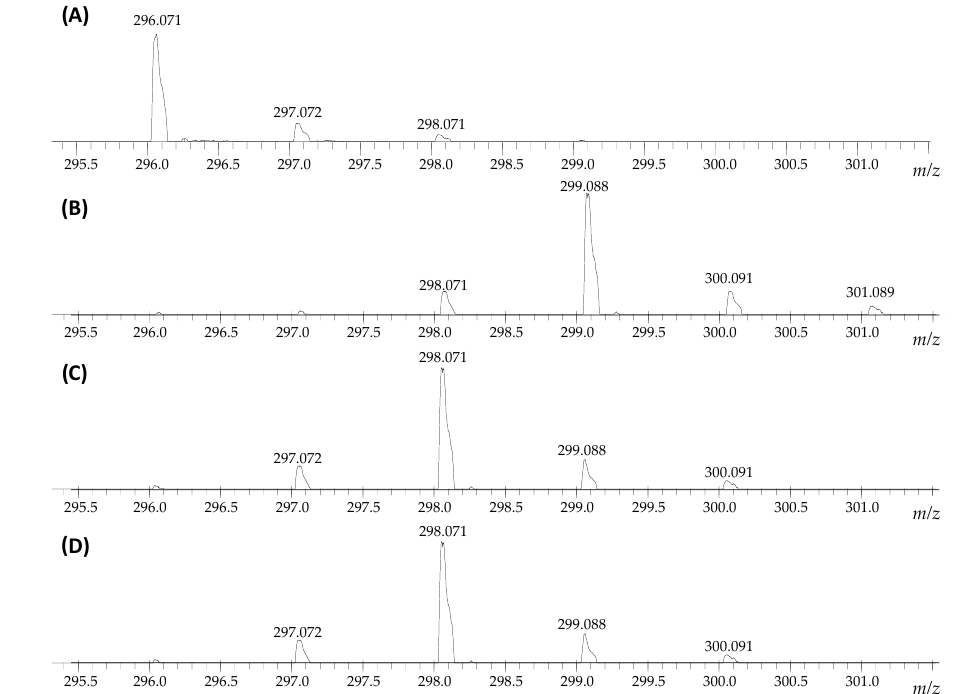
Figure 2. Fragment of the ESI-MS spectra presenting isotope pattern of sodium adduct of armodafinil ion ( A ) before HDX and after 1 h incubation of the sample at 50 ◦ C in the mixture of ( B ) 1% TEA/D 2 O/MeCN, ( C ) 1% TEA/MeOD, ( D ) 1% TEA/MeOD/TBME, lyophilization and treated by the mixture of H 2 O/MeCN/HCOOH (50/50/0.1 v/v/v ).